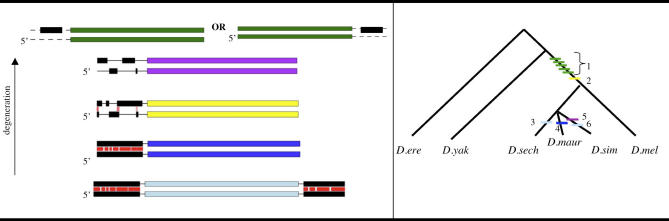
A Simplified Schematic of the Repetitive Sequence Flanking New Genes and Their Distribution over the D. melanogaster Subgroup PhylogenyLeft panel displays the varying degrees of identity and degeneration between flanking regions of paralogs, with the right panel displaying the branches in which they are found; 1: (CG2952:CG2952-r), (kep1: CG4021), (kep1:CG9337), (CG9902:CG7692), (kep1:CG3875); 2: (CG3875-CG3927); 3: (CG9337-CG9337-r); 4: (mkgr-mkgr2); 5: (CR9337-CR33318); 6: (CG3101-CG3101-r). The red blocks in the left panel indicate alignable regions of the TEs and other repeat sequences. The black boxes represent sequences of TEs and other repeats; fragmented black boxes represent RE fragments. The long boxes in various colors represent the identified new genes. See also Figure S1, for the alignments.